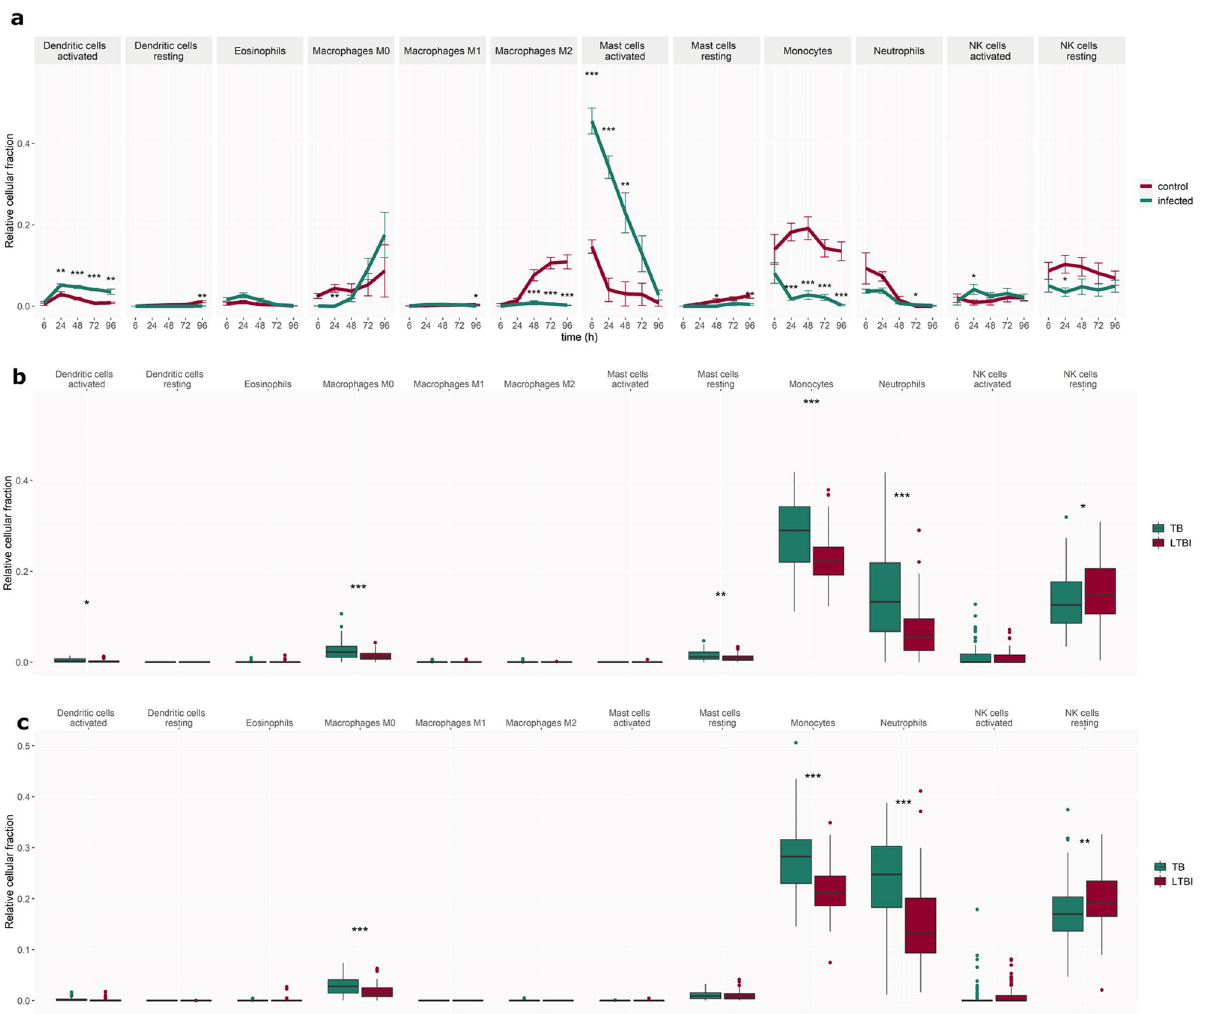
Figure 7. Cell deconvolution using CibersortX—innate cells. Changes in innate cell fractions ( a ) in vitro over time in the Mtb -infected and control group and in vivo in ( b ) paediatric TB patients and ( c ) adult TB patients and corresponding LTBI control patient groups. Error bars depict standard deviation from the mean, *p < 0.05, **p < 0.005, ***p <